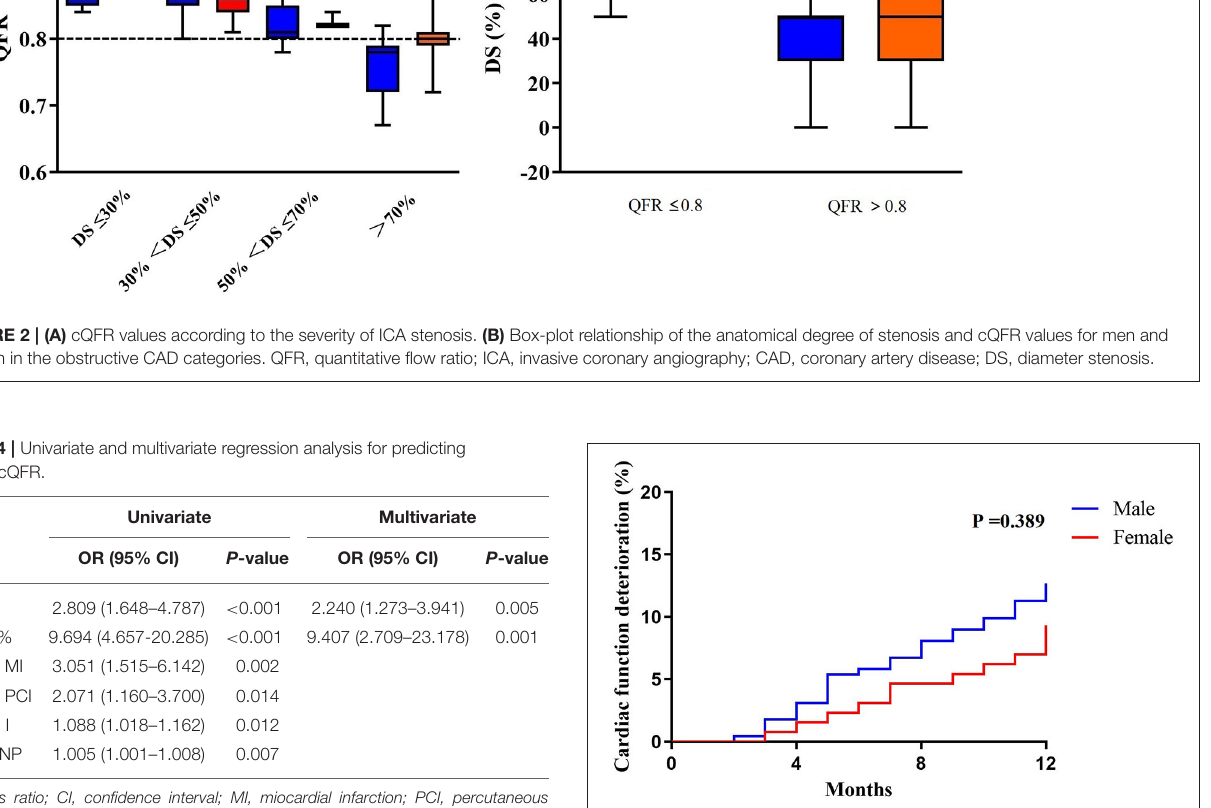
complaints, complications and mortality compared to men